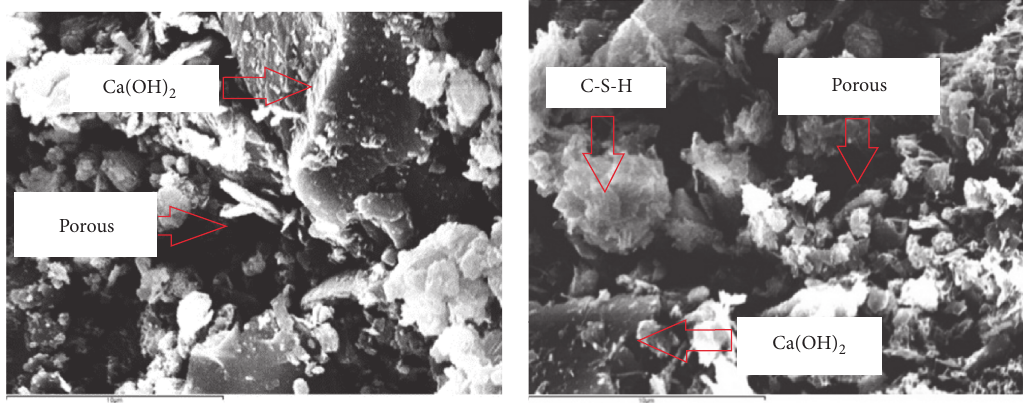
Figure 9: SEM image of cemented tailing